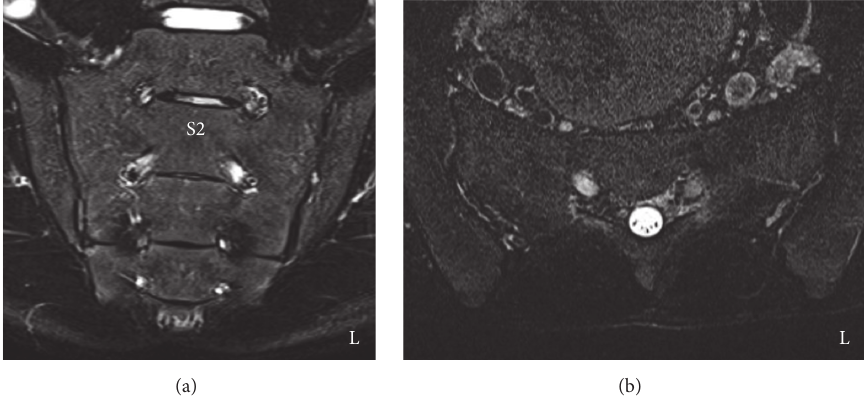
Figure 4: Magnetic resonance images of the sacrum one year after conservative treatment. (a) Coronal plane on a short TI inversion recovery (STIR) image. (b) Axial plane at the S2 level on a STIR image. Coronal plane (a) and axial plane at the S2 level (b) on a STIR image show no abnormal signal intensity. These radiological findings indicated bone union of the sacral stress